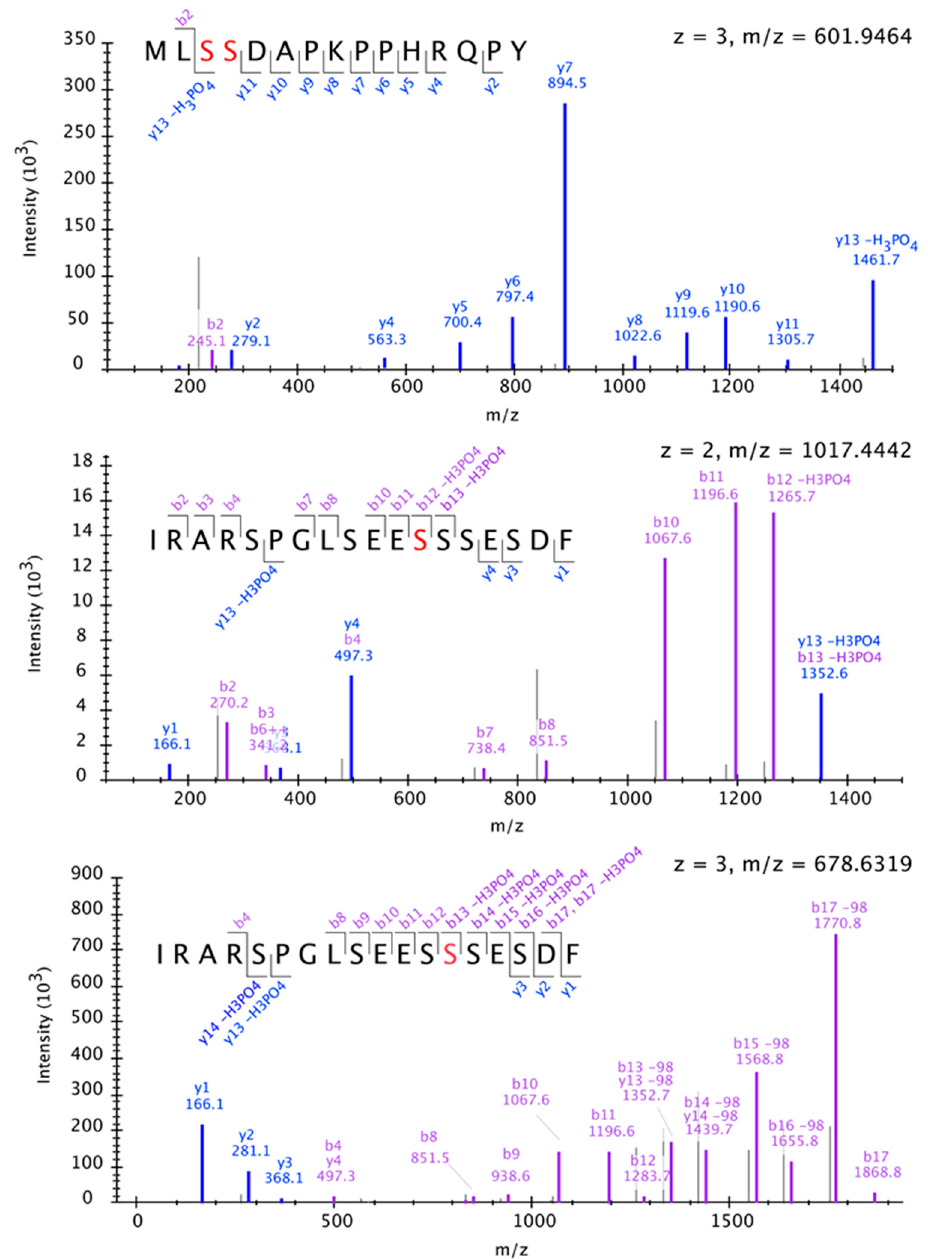
Figure 9. Mass spectrometry analysis of TCO residues phosphorylated by CK2. Representative annotated spectra for the phosphorylation sites identified are shown. Observed fragment ions are annotated in the displayed peptide sequences, with phosphorylation sites indicated by red-colored amino acids. Each peptide contains only a single phosphorylation site; however, in the case of the peptide MLSSDAPKPPHRQPY (top), the exact site of phosphorylation is ambiguous between two adjacent serine residues.